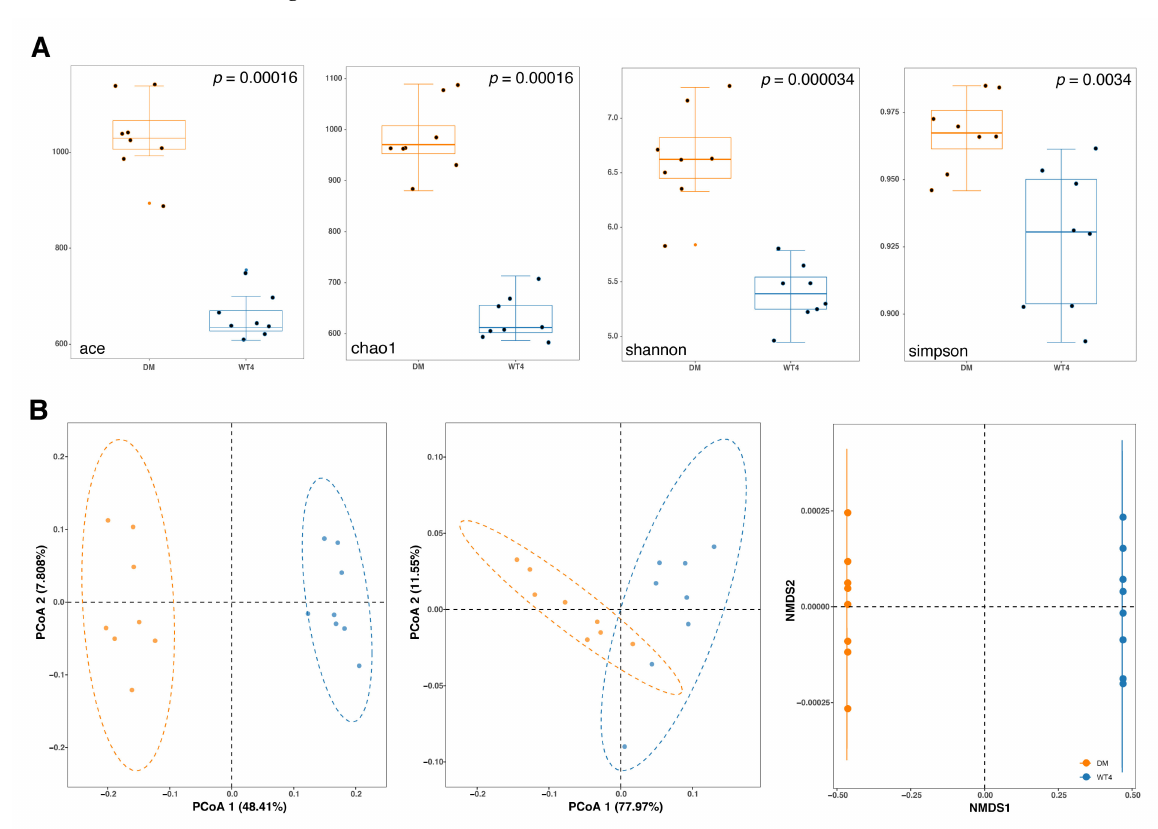
Figure 5. Bacterial diversity assessment. ( A ) Comparisons of α -diversity. The abundance-based coverage estimators (ACE), Chao1, Shannon, and Simpson indexes are displayed. ( B ) Principle coordinate analysis (PCoA) based on weighted or unweighted unifrac distance and NMDS are shown from left to